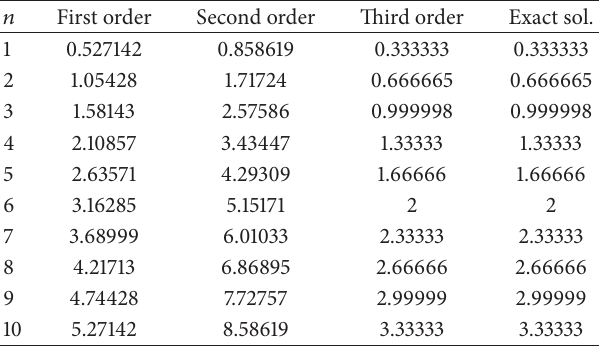
Table 2: Comparisons of first, second, and third order and exact solutions at different values of 𝑛 at 𝑡 = 1 .